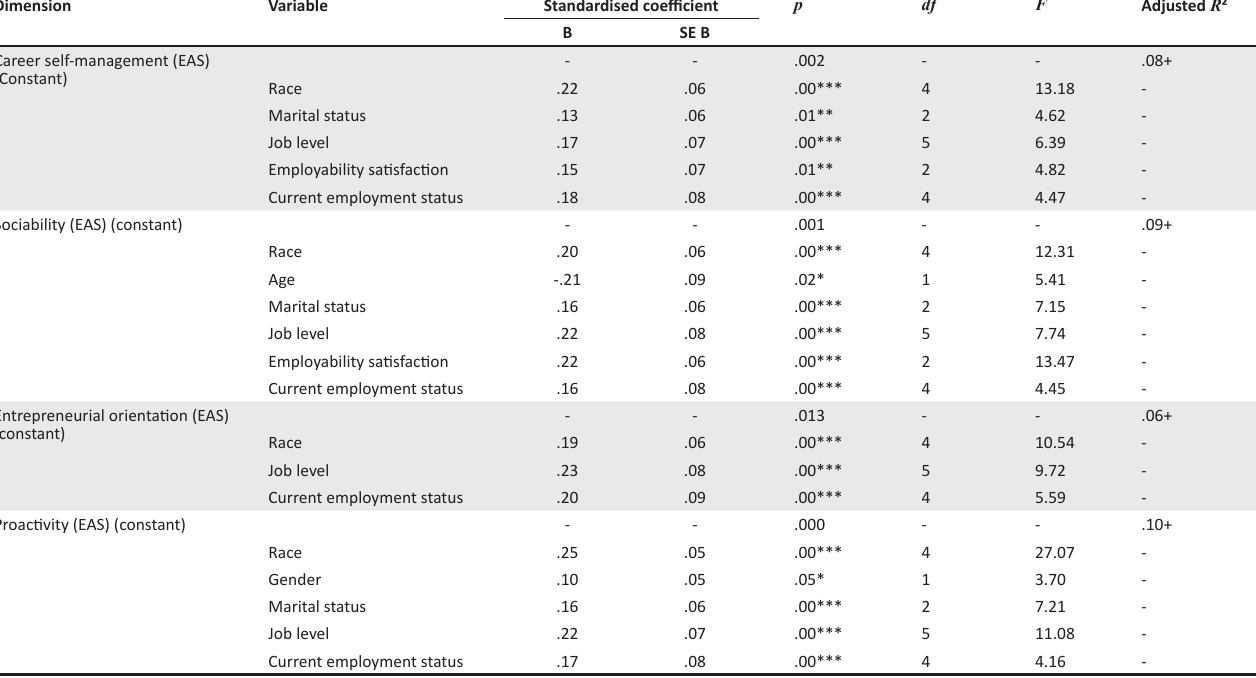
TABLE 6: Categorical regression analysis – Employability Attributes Scale.